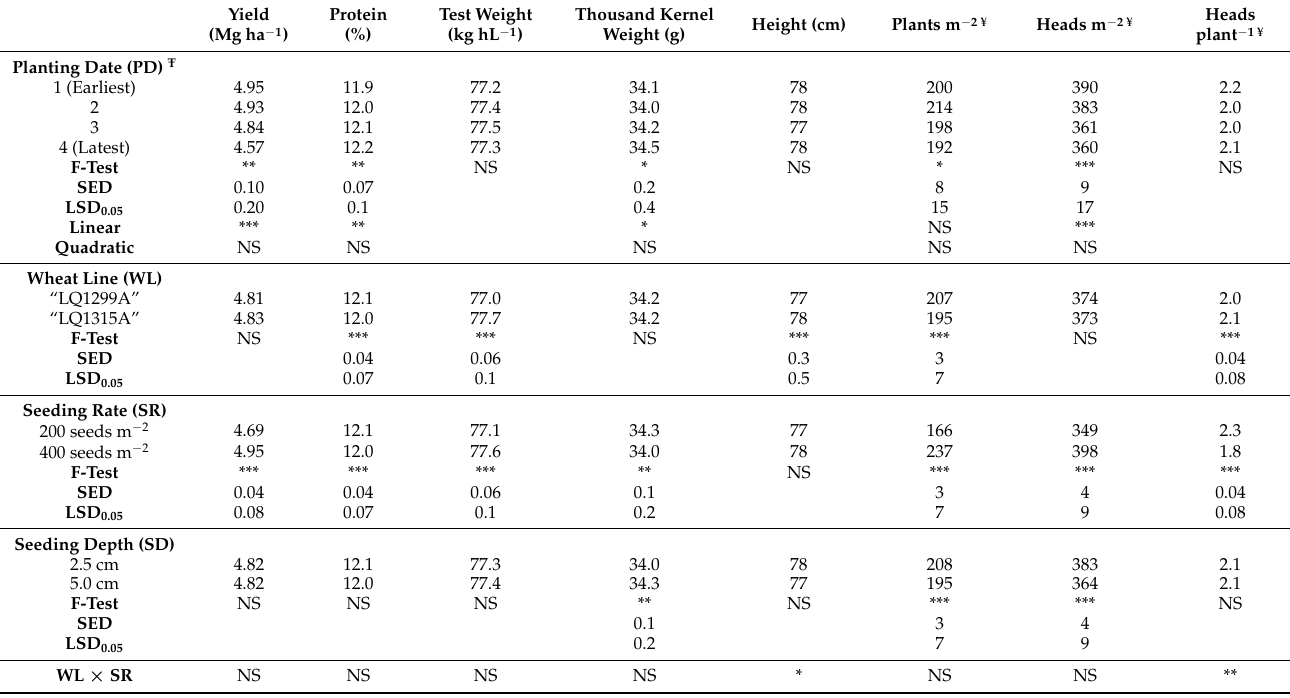
Table 3. Least square means for grain yield, grain quality, and select agronomic parameters affected by ultra-early planting.